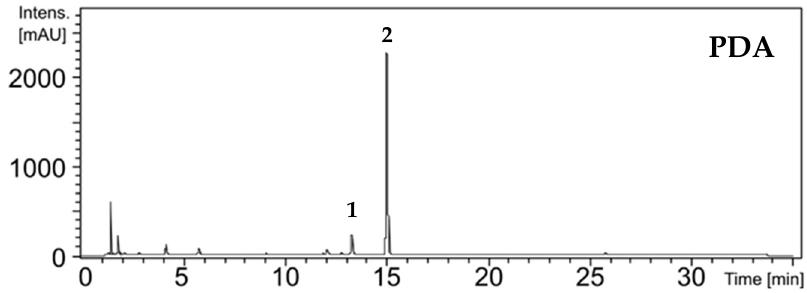
Figure 1. Example of chromatogram obtained from PDA crude extract of MPO620 strain ( Hypoxylon sp.). Compounds 1 and 2 were identified as 7-dechlorogriseofulvin and griseofulvin, respectively. To assess the variation in the production of griseofulvin derivatives, the three strains were submitted to six culture conditions for 28 days (see Experimental section).